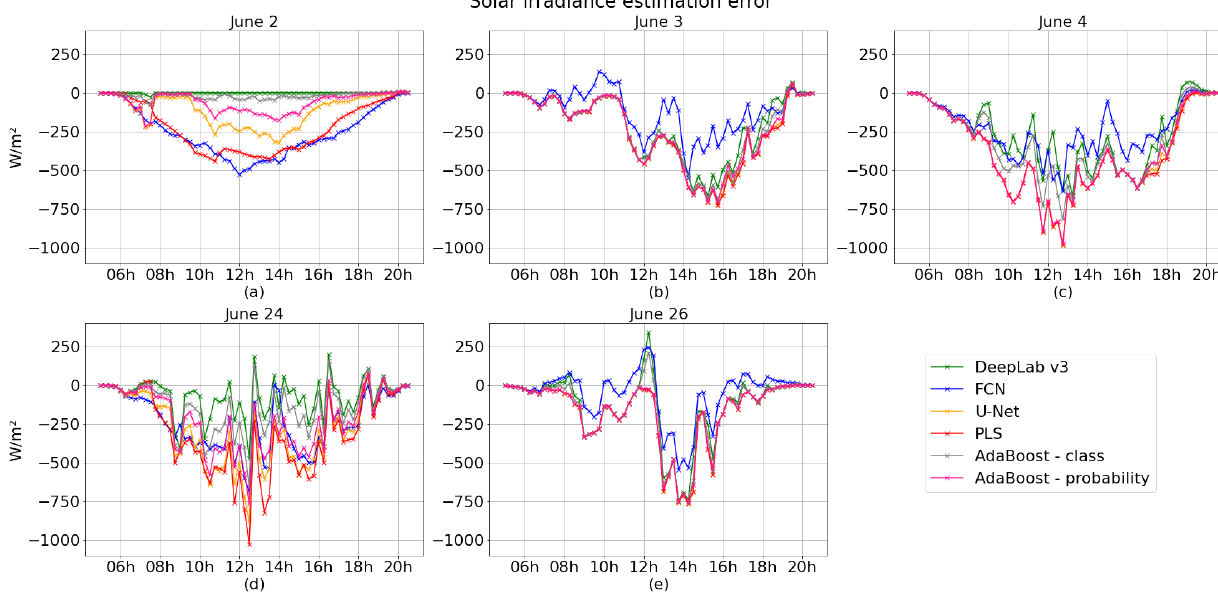
Figure 6. Solar irradiance estimation error in W/m 2 . The results are shown for the cloud types ( a ) clear sky, ( b , c ) haze clouds, ( d ) partially cloudy sky, and ( e )